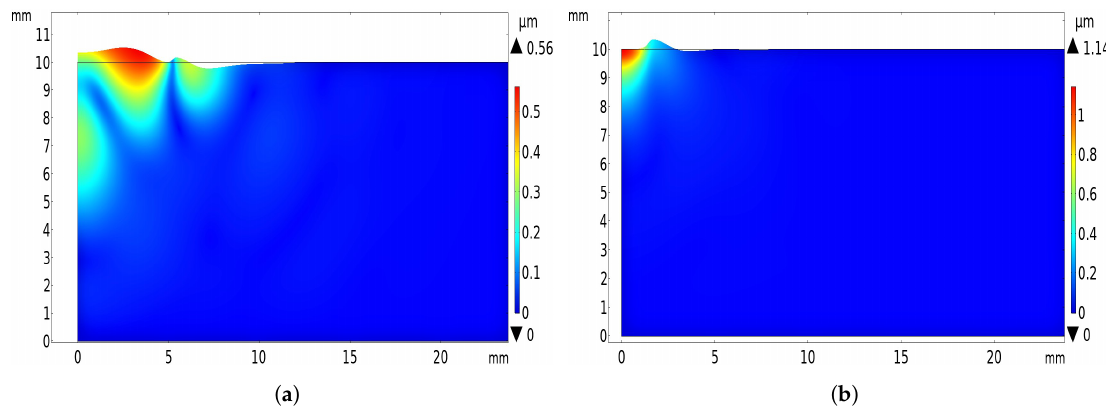
Figure 18. Surface plot of the displacement amplitude z -component in the pipette with gap boundary condition; ( a ) pipette radius 5.25 mm; ( b ) pipette radius 1.25